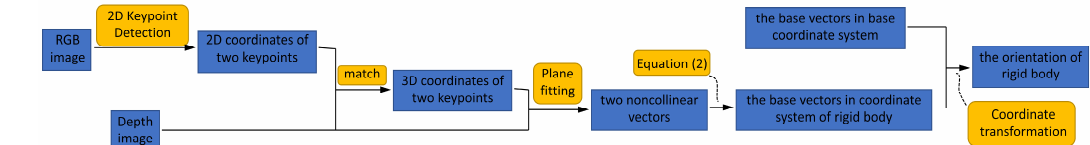
Figure 4. Novel pose estimation method.